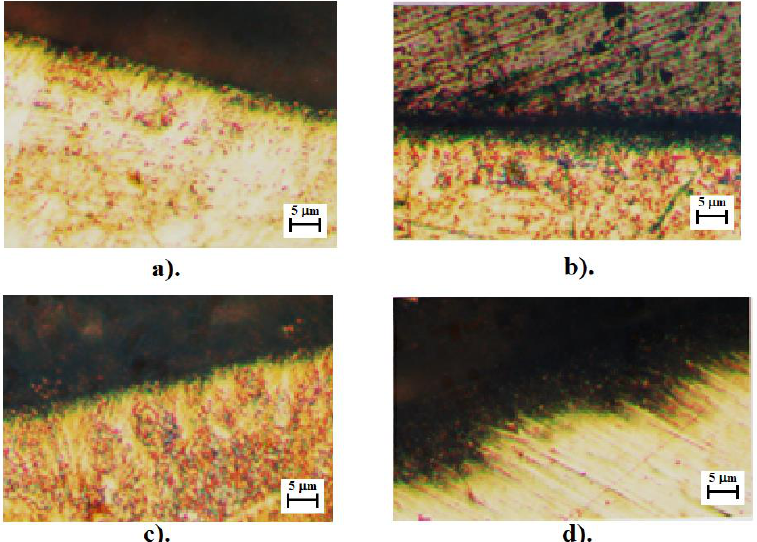
Figure 12. The topography of the manufactured surface: ( a ) workpiece hardness HB = 300; ( b ) workpiece hardness HB = 400; and ( c ) workpiece hardness HB = 200.